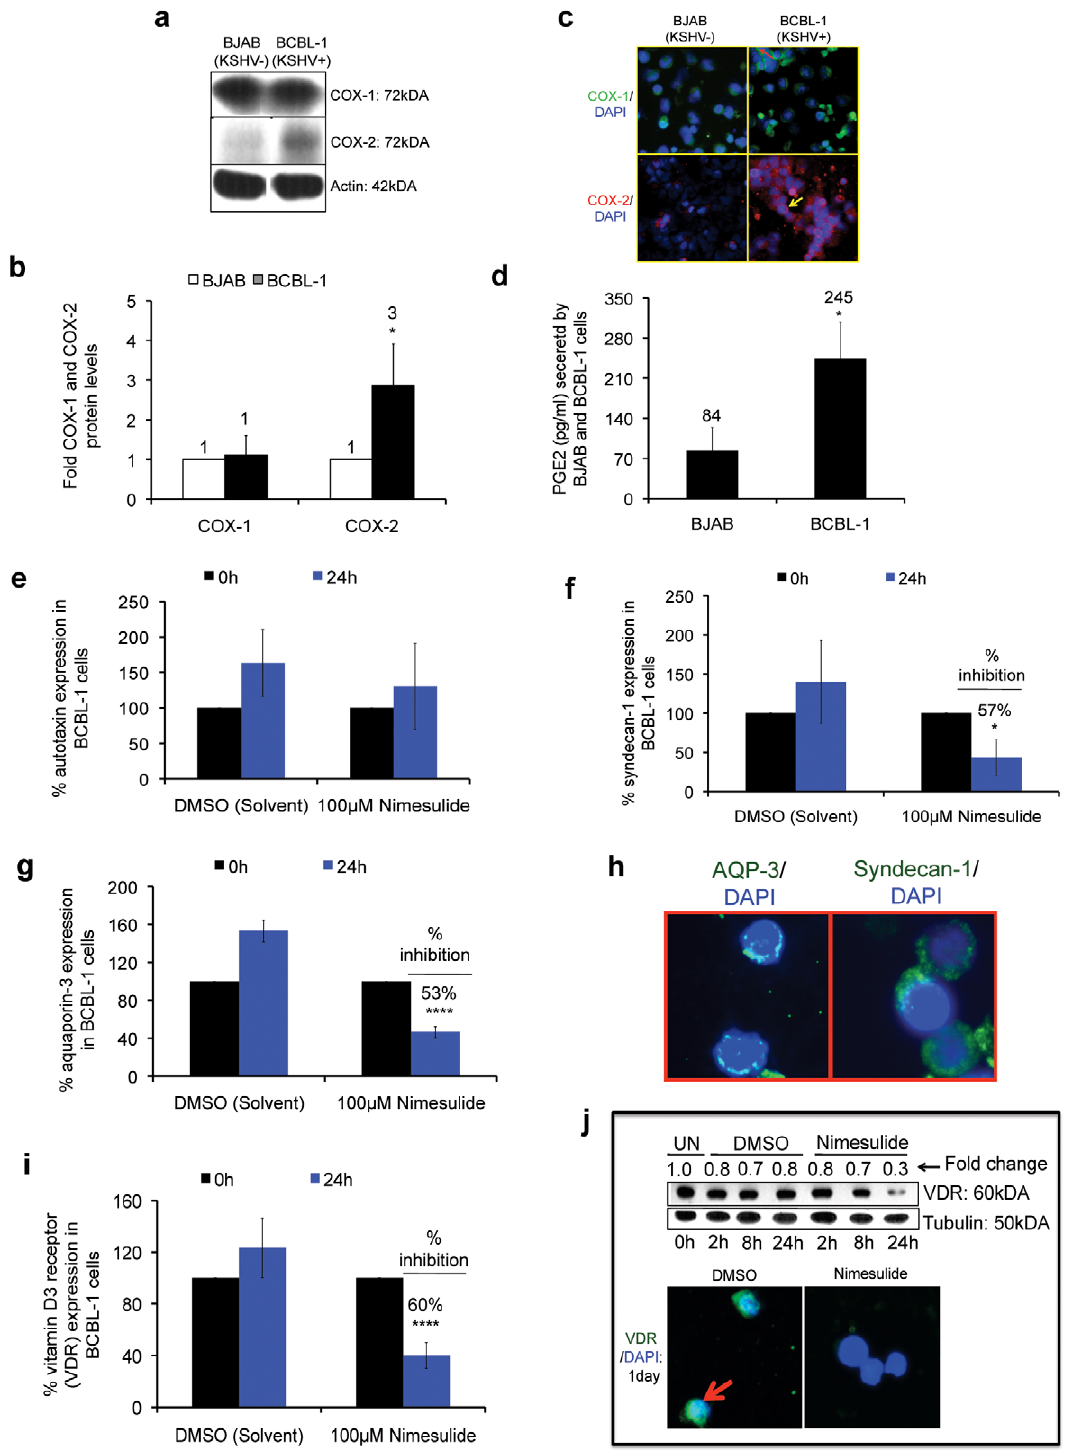
Figure 10. COX-2/PGE2 status in BCBL-1 cells and effect of nimesulide on PEL specific genes. ( a–b ) Total lysates from 5 6 10 5 BCBL-1 and BJAB cells were immunoblotted ( a ) for COX-1 and COX-2. ( b ) Protein band intensity was measured by densitometry and normalized with respect to actin to quantitate the relative differences and the fold difference was calculated with respect to BJAB cells. ( c–d ) In parallel experiments, COX-1/COX- 2 protein levels and secreted PGE2 in the supernatant of BCBL-1 and BJAB cells were examined by immunofluorescence ( c ) and ELISA ( d ), respectively. The fold change and statistics (t-test) were calculated with respect to BJAB cells. ( b, d ) Each experiment was done in tripicate, and each point represents the average 6 S.D. from three independent experiments. (*) p , 0.05. ( e, f, h, i ) 5 6 10 5 BCBL-1 cells were seeded with 100 m M nimesulide or DMSO or left untreated without replenishment with fresh media. RNA was isolated at 24 h post-treatment with the drug to examine the gene expression levels of aquaporin-3 ( e ), syndecan-1 ( f ), autotoxin ( h ), and VDR ( i ) by real-time RT-PCR. The cells were neither replenished with fresh media nor supplemented with the drugs. The fold change and corresponding statistics (t-test) were calculated with respect to untreated cells